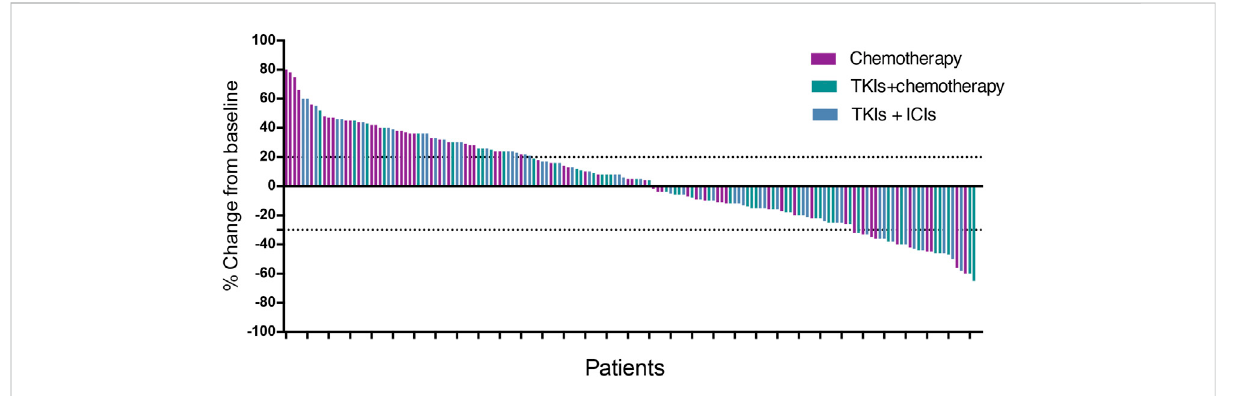
FIGURE 1 Waterfall plot of the best response change.